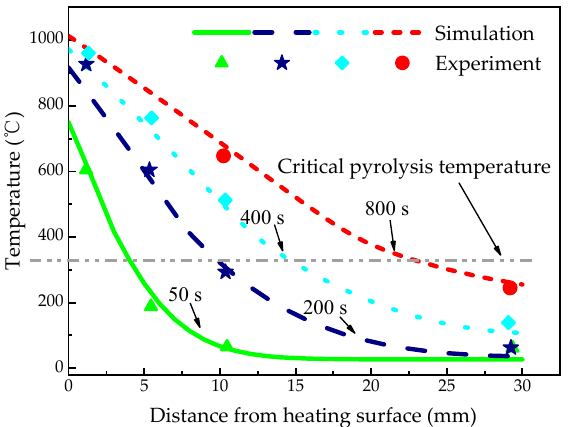
Figure 5. Spatially dependent temperature profiles of the glass fiber/phenolic resin composites specimen under one-sided heating.